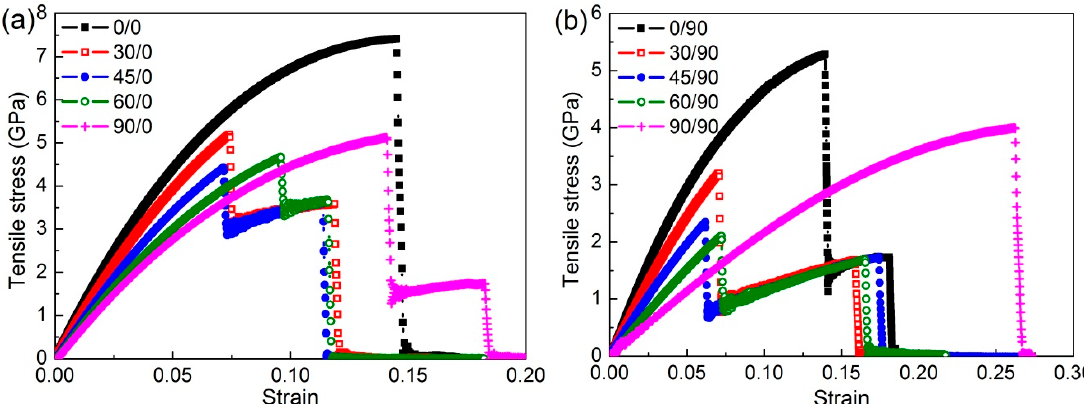
Figure 2. Tensile stress-strain curves of the angle-ply DLBP in ( a ) X-axis; and ( b ) Y-axis directions. The numerical numbers in legend denote stacking angle θ T / θ B .